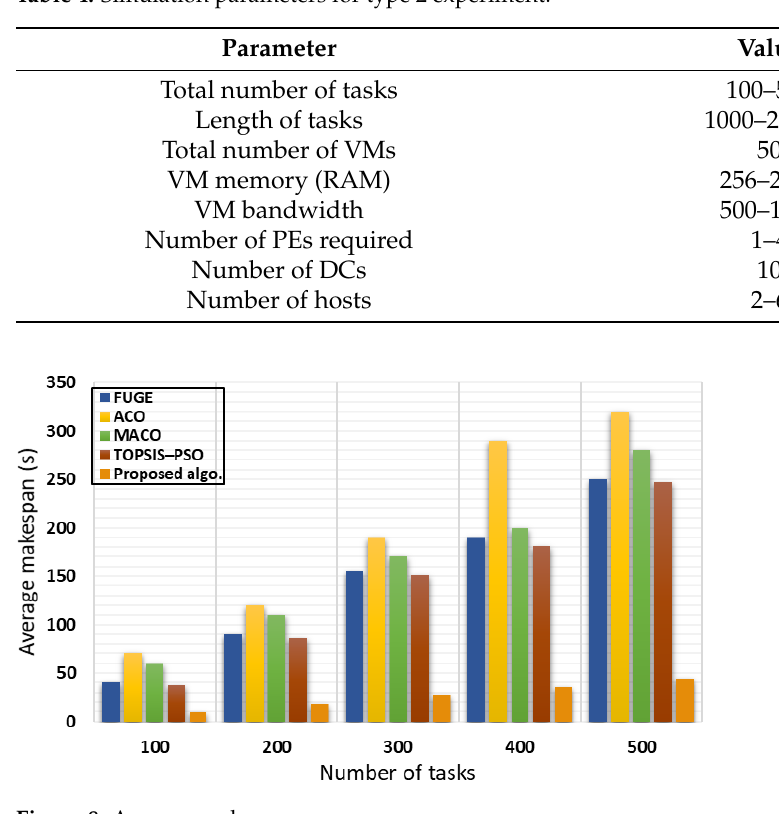
Figure 8. Average